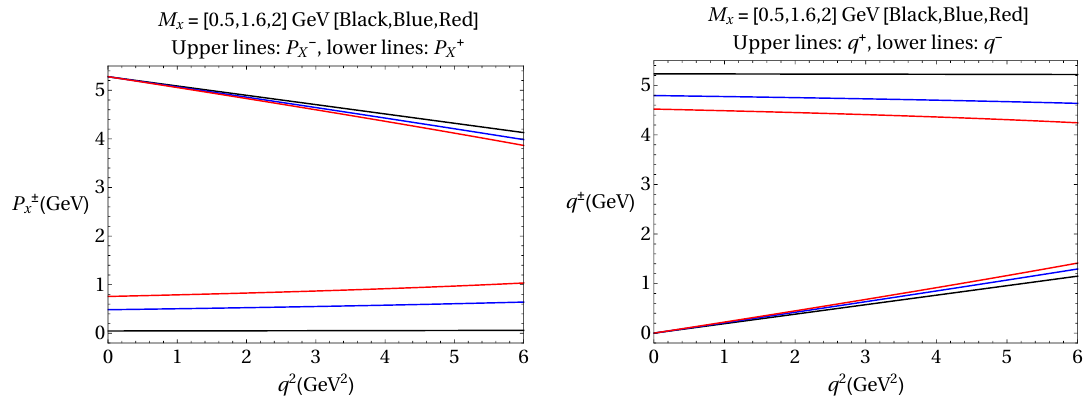
= n P X and X (cid:1) q and q (cid:0) = (cid:22) n q is plotted as a function of q 2 (cid:1) (cid:1)